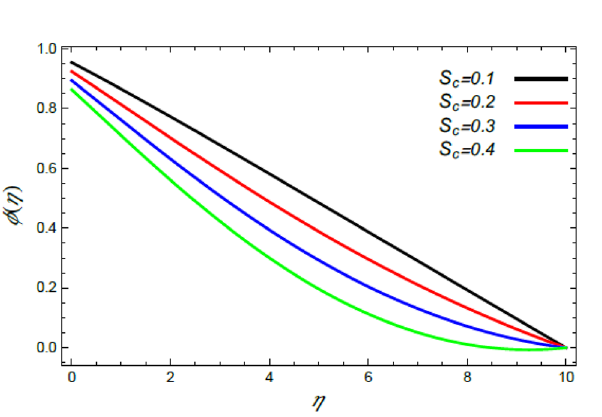
Figure 23. Variation of the nanoparticle concentration ϕ(η) versus η as given in Eq. (67) to illustrate the impact of the Schmidt numeral S c